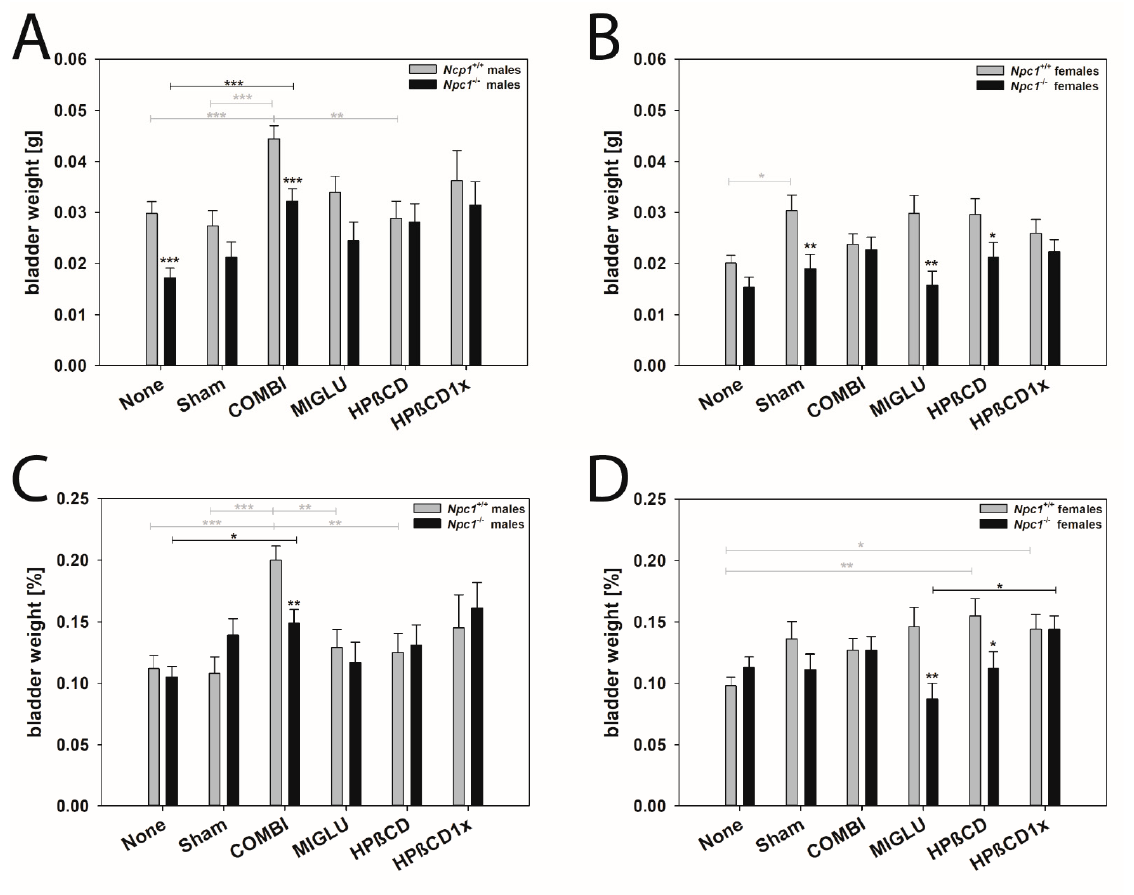
Figure 8. Bladder weight ( A , B ) and relative bladder weight ( C , D ) of Npc1 mice. Male ( A , C ) and female ( B , D ) mice. Significant post-hoc tests are indicated by asterisks (* p < 0.05, ** p < 0.01, *** p < 0.001). Data are means ± SEM.